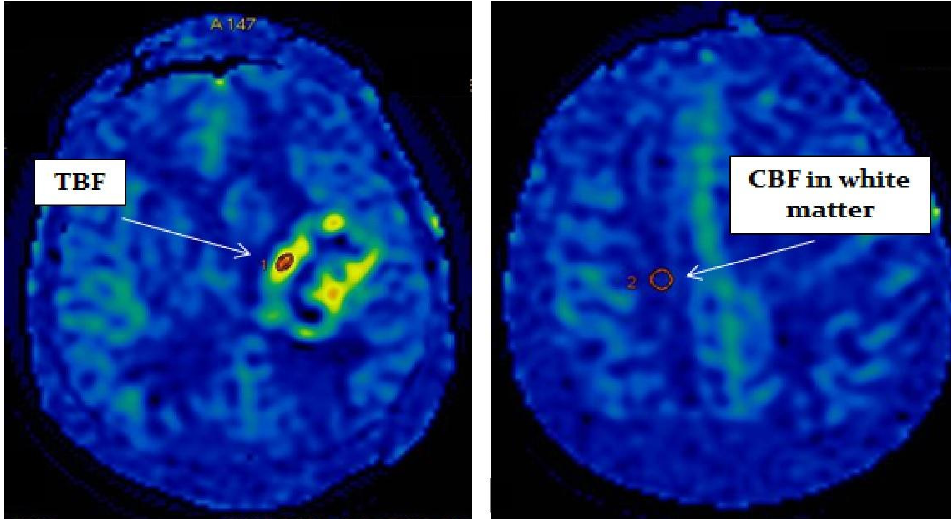
Figure 1. Blood flow measurement on parametric maps.